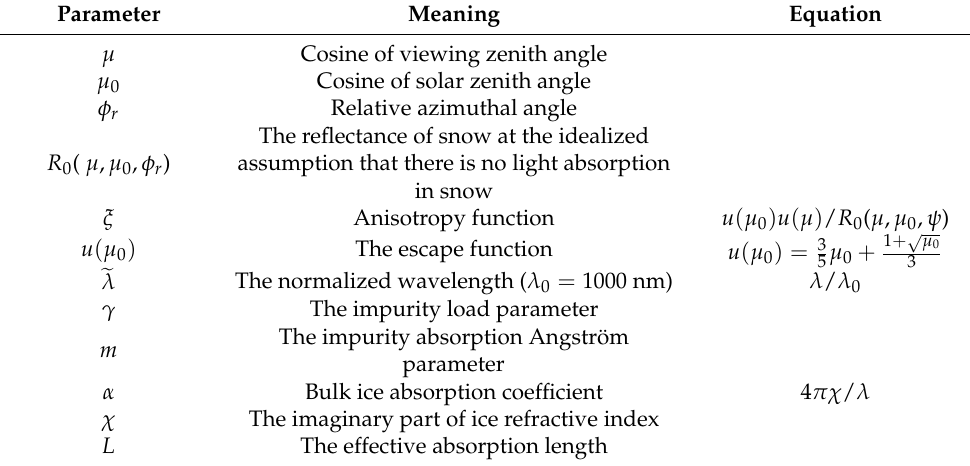
Table 2. Description of parameters in Equations (12) and (13). Parameter Meaning Equation µ Cosine of viewing zenith angle µ 0 Cosine of solar zenith angle The reflectance of snow at the idealized assumption that there is no light absorption in